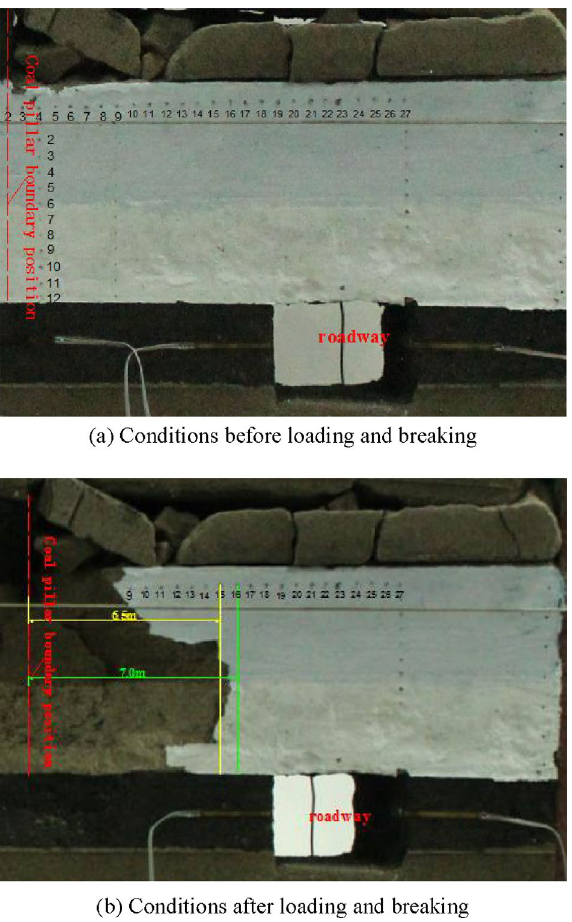
Figure 13. State of coal and rock strata at roadway coal pillar side before or after